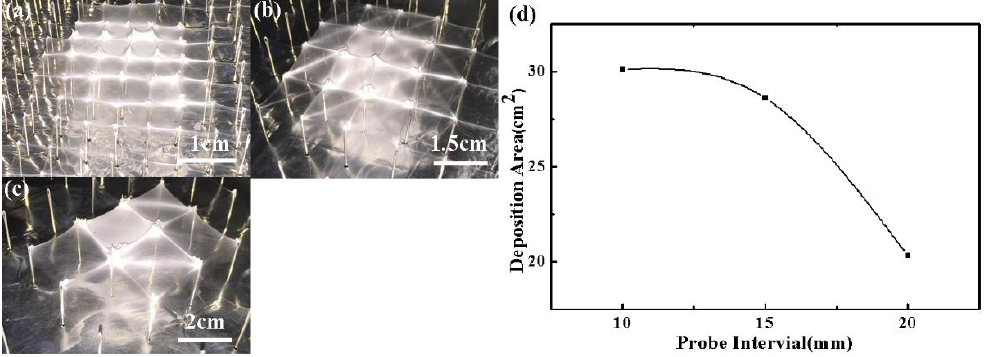
Figure 6. Effect of probe intervals on the printed 3D nanofibrous structures. ( a ) 10 mm; ( b ) 15 mm; ( c ) 20 mm; ( d ) relationship between deposition area and probe interval. The probe height, applied voltage, and flow rate were 20 mm, 25 kV, and 300 μL/h, respectively.